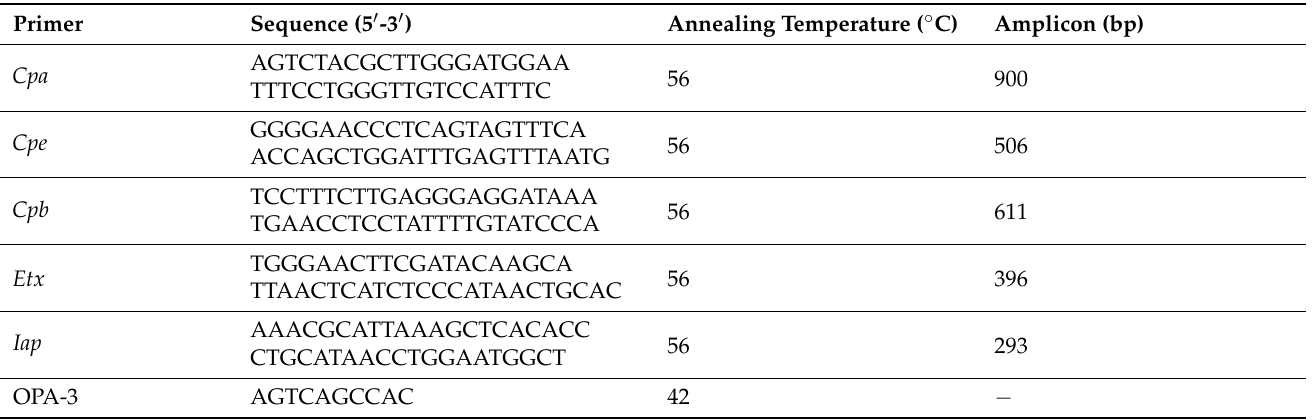
Table 4. Primer sequences used in this study for the genotyping and detection of C. perfringens toxin-encoding